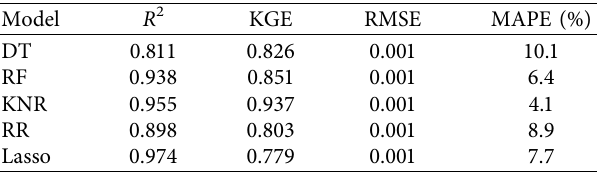
Table 3: Te calculated performance metrics for the oil fracture porosity over the testing phase.